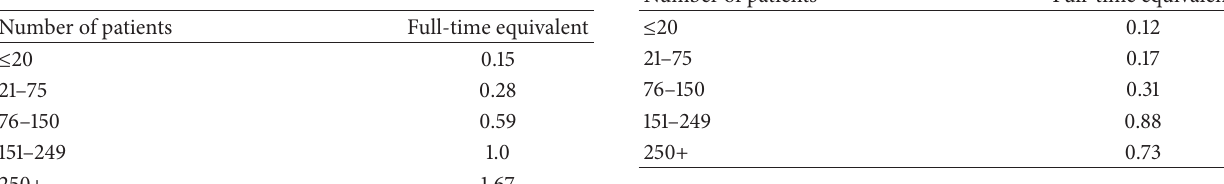
Table 3: Dietitian/nutritionist.